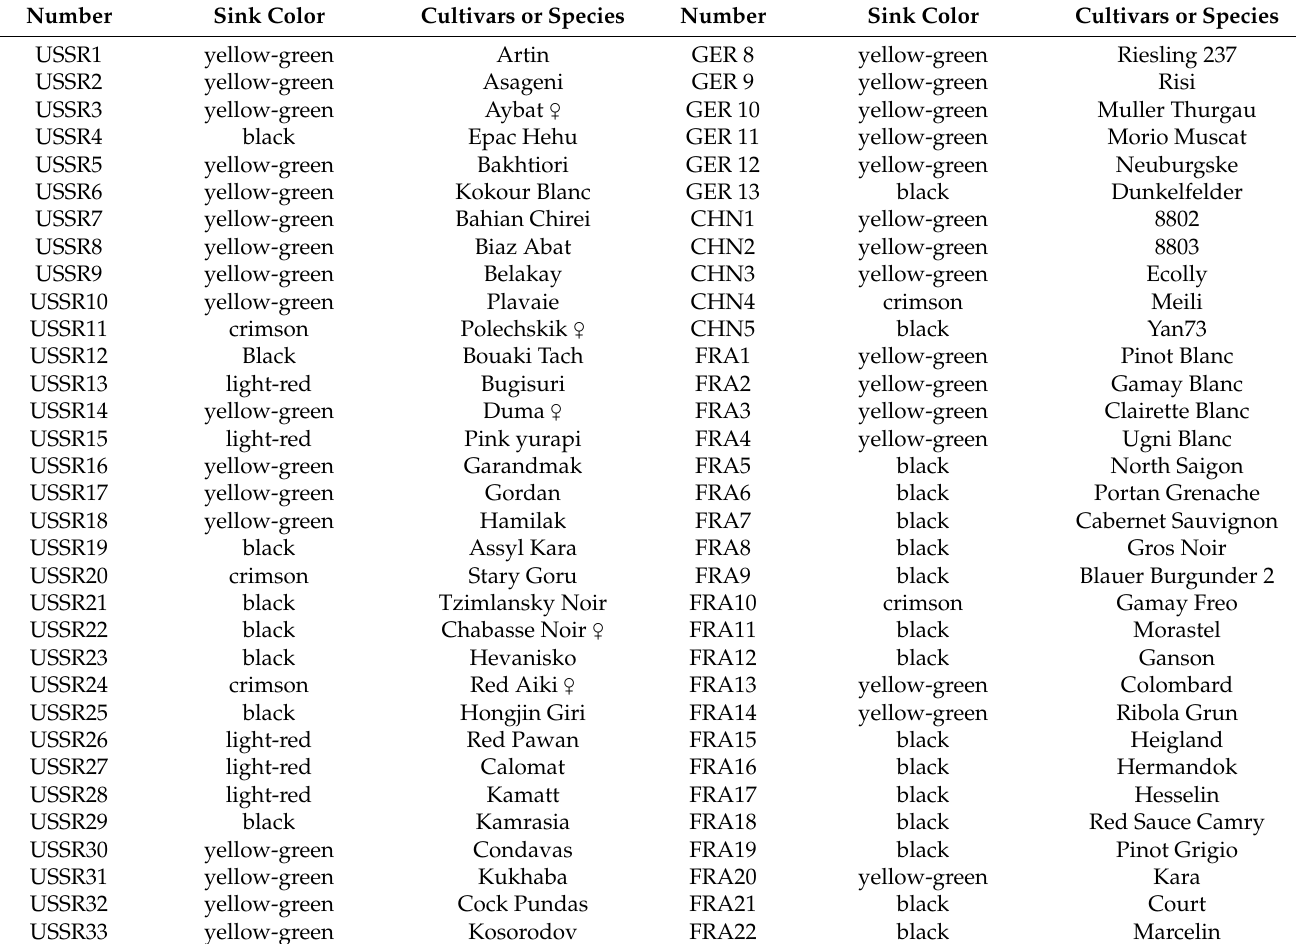
Table 1. Grape varieties or strains used in this study.